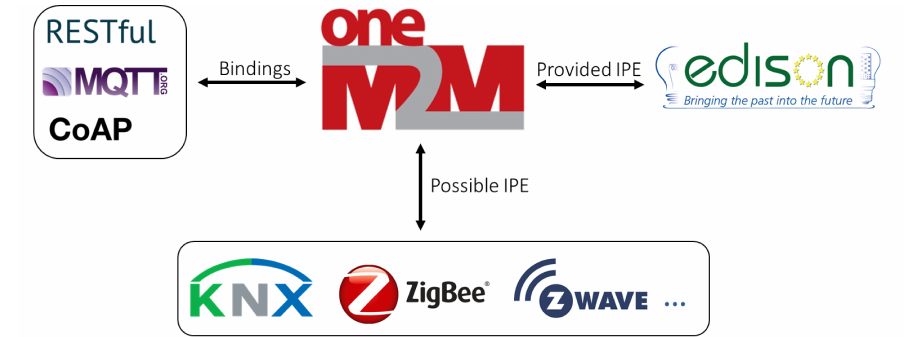
Figure 10. OneM2M horizontal Internet of things platform with supported bindings, provided EDISON Interworking Proxy Entity (IPE) and possible IPEs for home and building automation